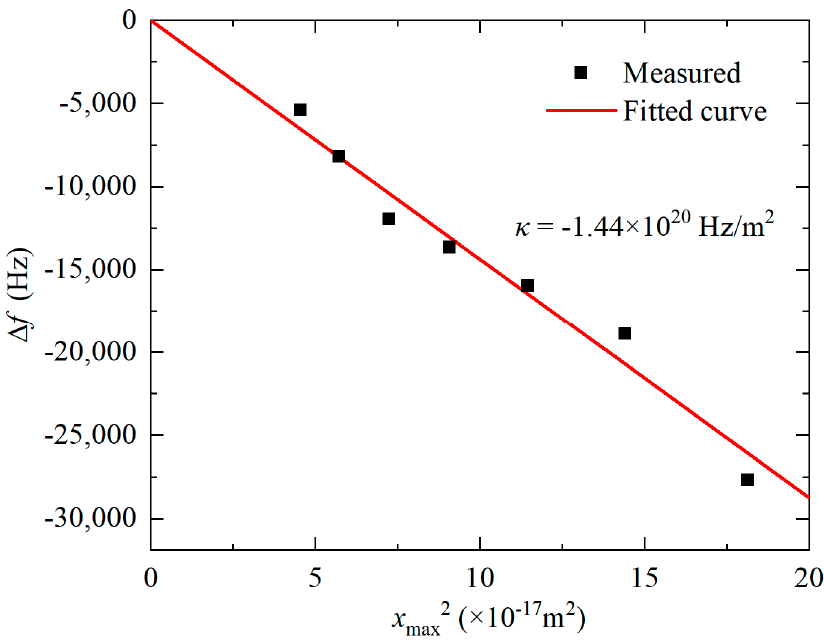
Figure 10. Relationship between ∆ f and x max2 for the Lame-mode resonator.